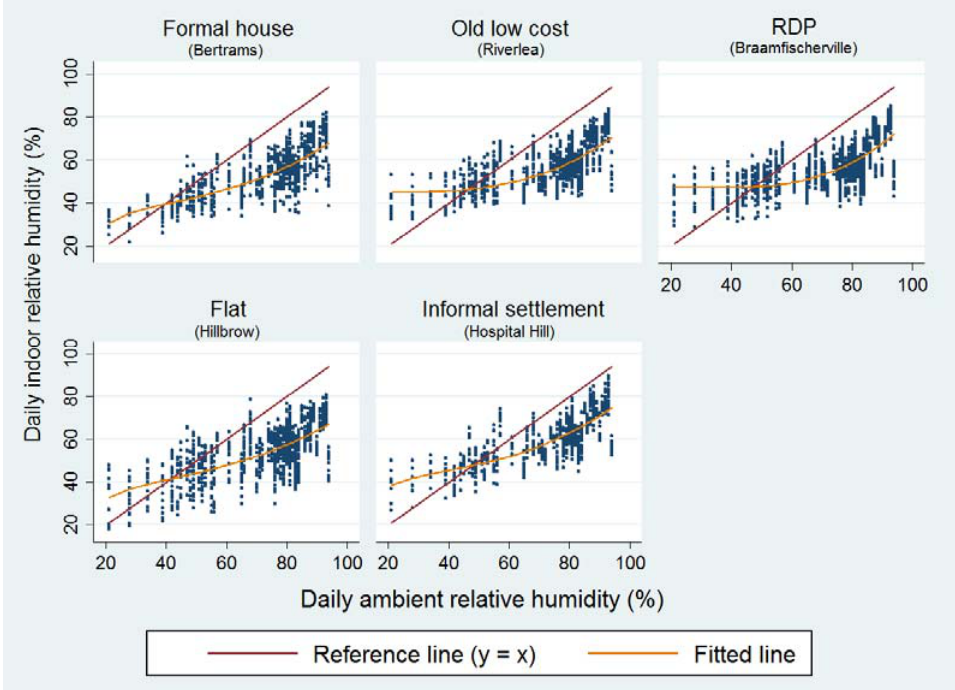
Figure 5. Daily mean relative humidity per housing type found in the five study sites. The reference line indicates a 1:1 match between indoor and ambient outdoor relative humidity (RH) values. The fitted line illustrates the deviation from the reference line.